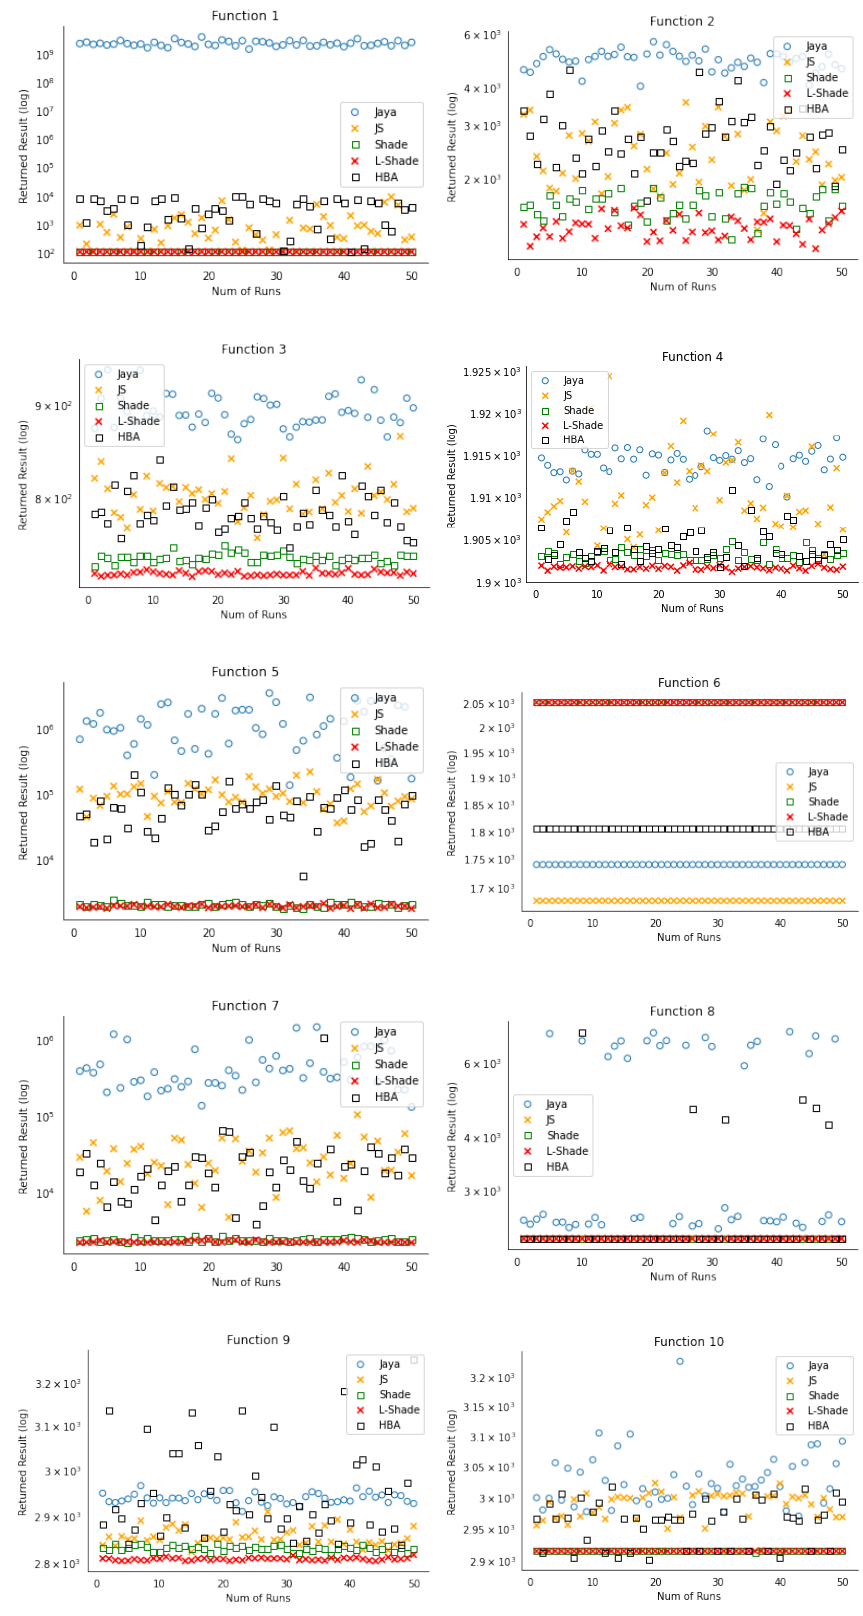
Figure 3. Scatter plots of the competing algorithms on the 10